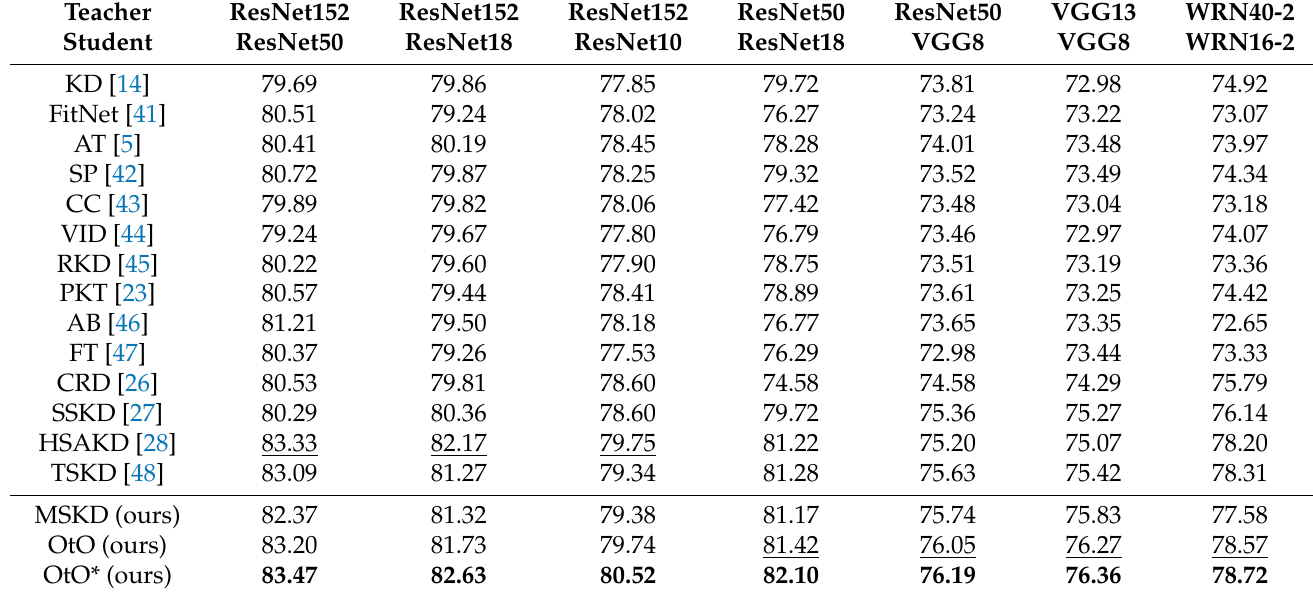
Table 4. Comparison of the accuracy (%) of our method with those of other KD methods for CIFAR100. The best and second-best results are shown in bold and underlined, respectively. “OtO*” denotes the results after data augmentation.